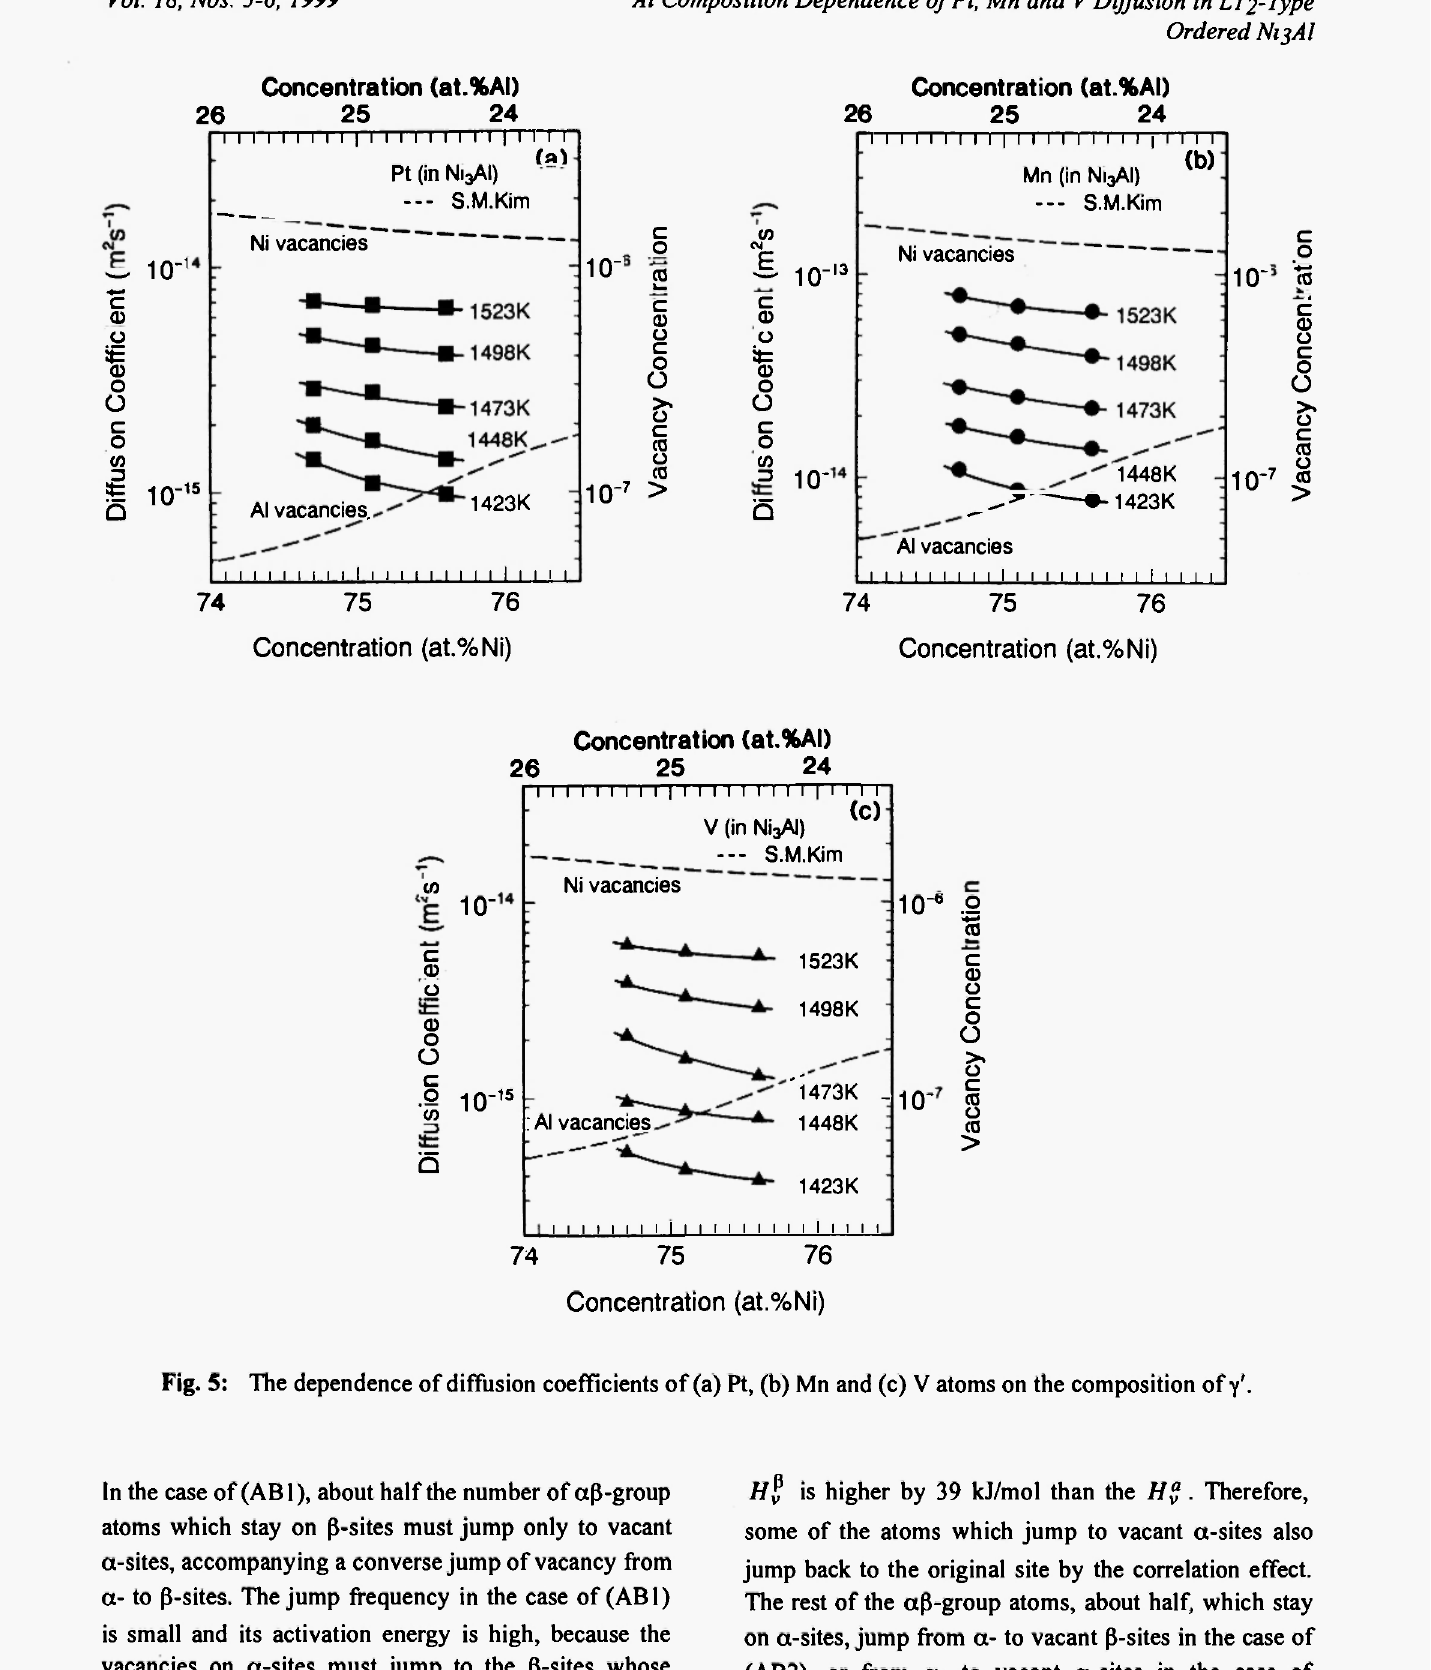
In the case of (ABl), about half the number of aß-group atoms which stay on ß-sites must jump only to vacant α-sites, accompanying a converse jump of vacancy from a- to ß-sites. The jump frequency in the case of (ABl) is small and its activation energy is high, because the vacancies on α-sites must jump to the ß-sites whose